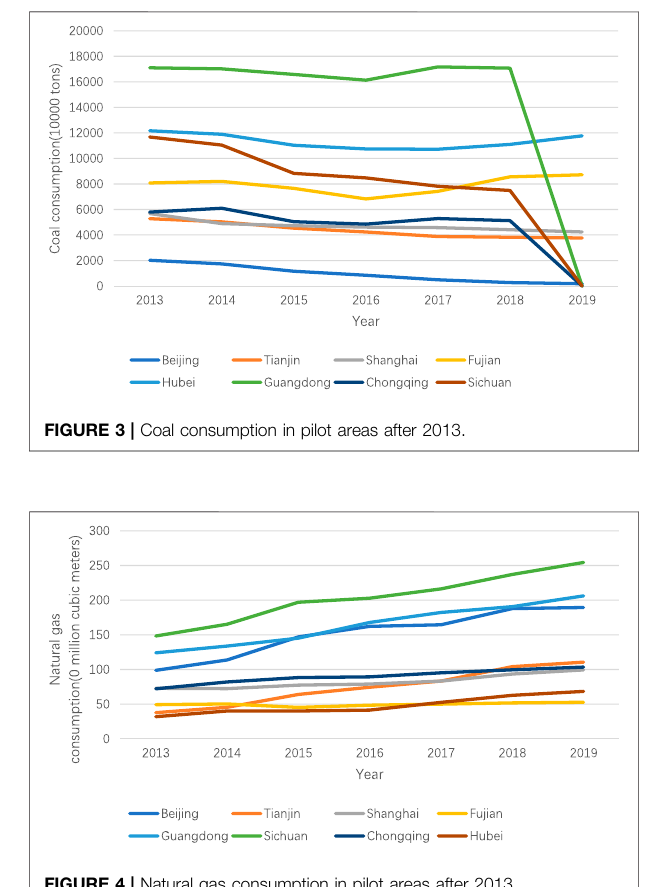
Frontiers in Environmental Science |